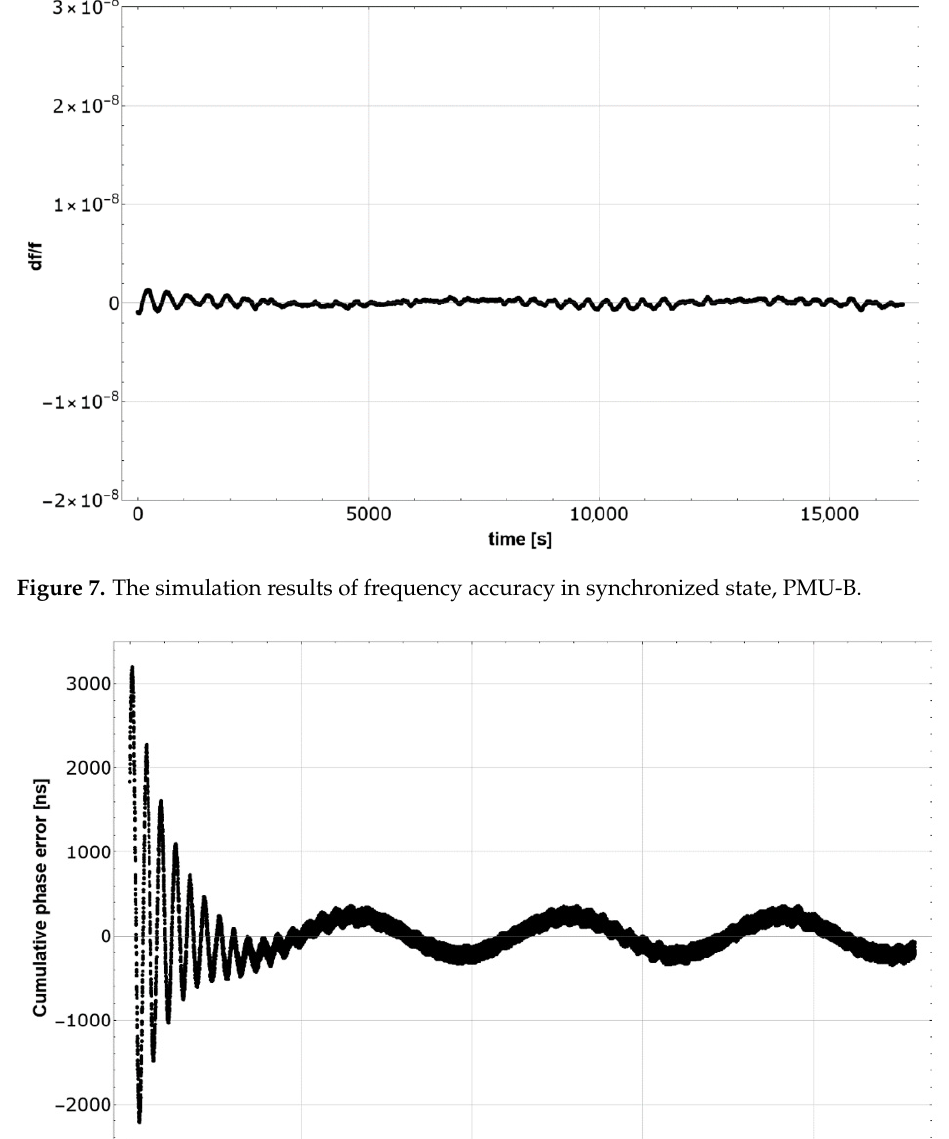
Figure 7. The simulation results of frequency accuracy in synchronized state, PMU-B.